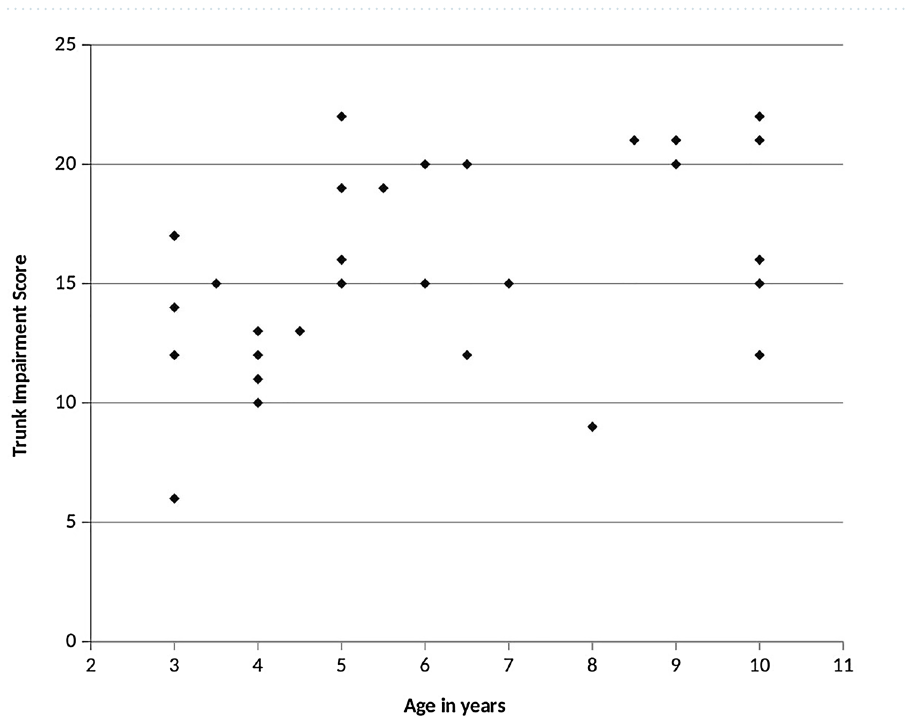
Figure 2. Scores trunk impairment scale based on the children’s